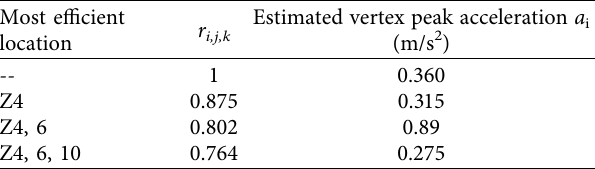
Table 13: Favorable arrangement of the outrigger with certain numbers.